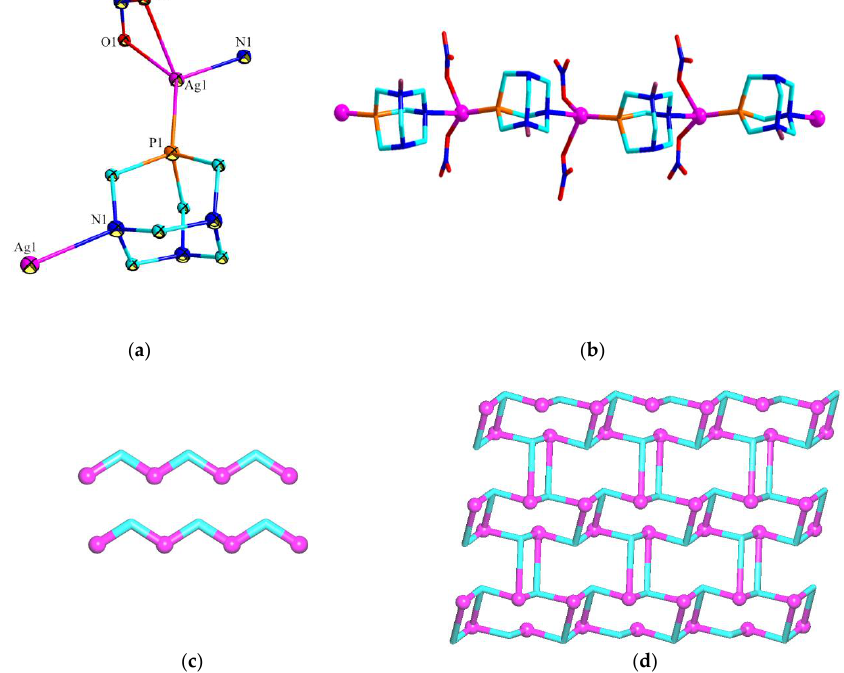
Figure 1. Structural fragments of 1 . ( a ) Elipsoid plot (50% probability). ( b ) 1D PTA-driven coordination chain; Ag (magenta balls), C (cyan), P (orange), N (blue), O (red). ( c ) Topological representation of two simplified 1D chains displaying a two-connected 2C1 topological net; Ag atoms (magenta balls), centroids of µ -PTAH linkers (cyan). ( d ) Topological view of the 2D hydrogen-bonded layer, displaying a uninodal 3-connected net with fes topology viewed along the b axis; centroids of [Ag(NO 3 ) 2 ] − nodes (magenta balls), centroids of PTAH nodes